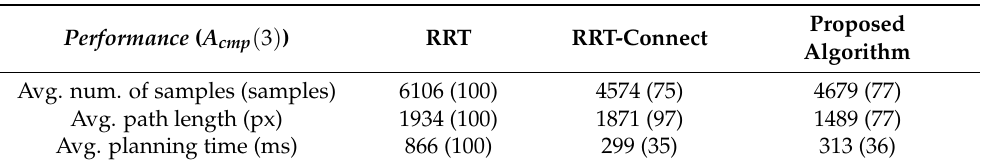
Table 4. Experimental result of Map 3 (the parentheses to the right of each value are the relative ratios based on RRT 100% ( x cmp ( 3 ) )).